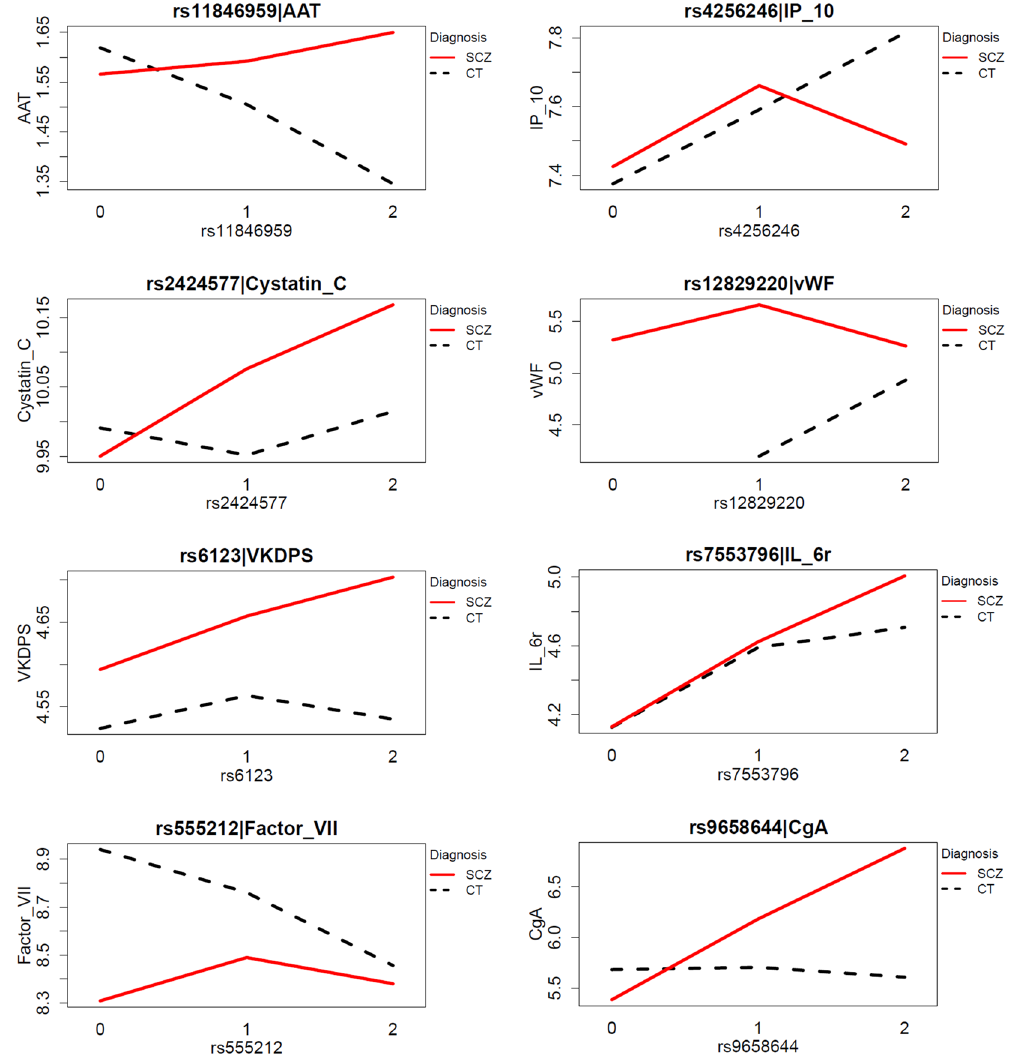
Figure 2. Interaction plots showing significant SNP and protein expression associations where SNP x Diagnosis interaction was